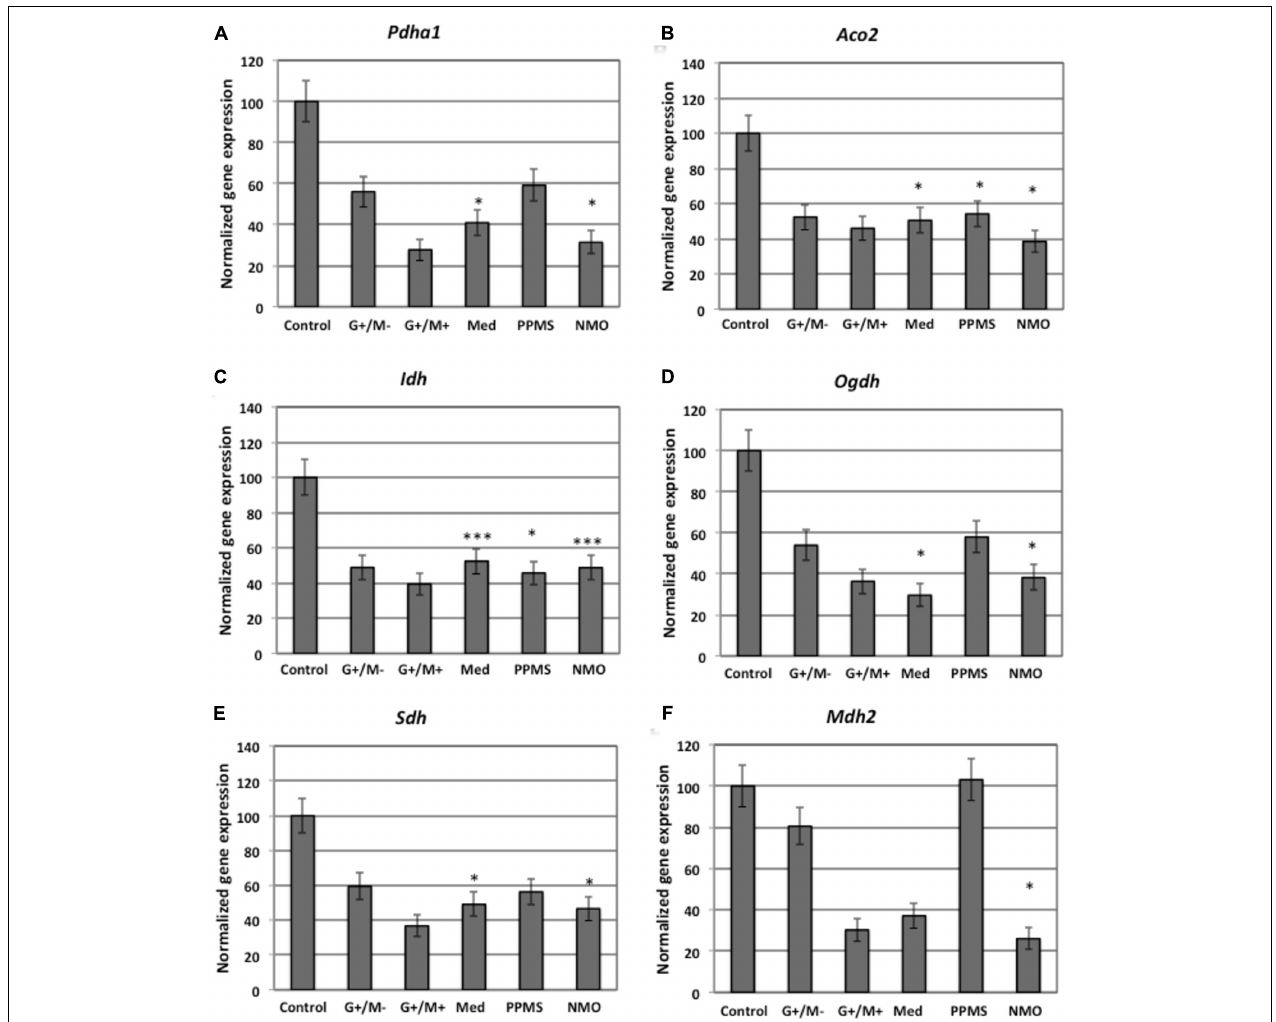
FIGURE 3 | Normalized expression of (A) Pdha1 ; (B) Aco2 ; (C) Idh ; (D) Ogdh ; (E) Sdh ; (F) Mdh2 genes involved in TCA cycle in OPCs treated with CSF of MS and NMO patients related to gene expression in OPCs treated with CSF of non-inflammatory neurological controls. OPCs: oligodendrocyte progenitor cells; Control: Neurons treated with CSF of non-inflammatory neurological controls; G + /M − and G + /M + : types of inflammatory MS; Med: Medullary MS; PP: Primary progressive multiple sclerosis; NMO: Neuromyelitis Optica. Four microarrays were used in each MS or NMO type of